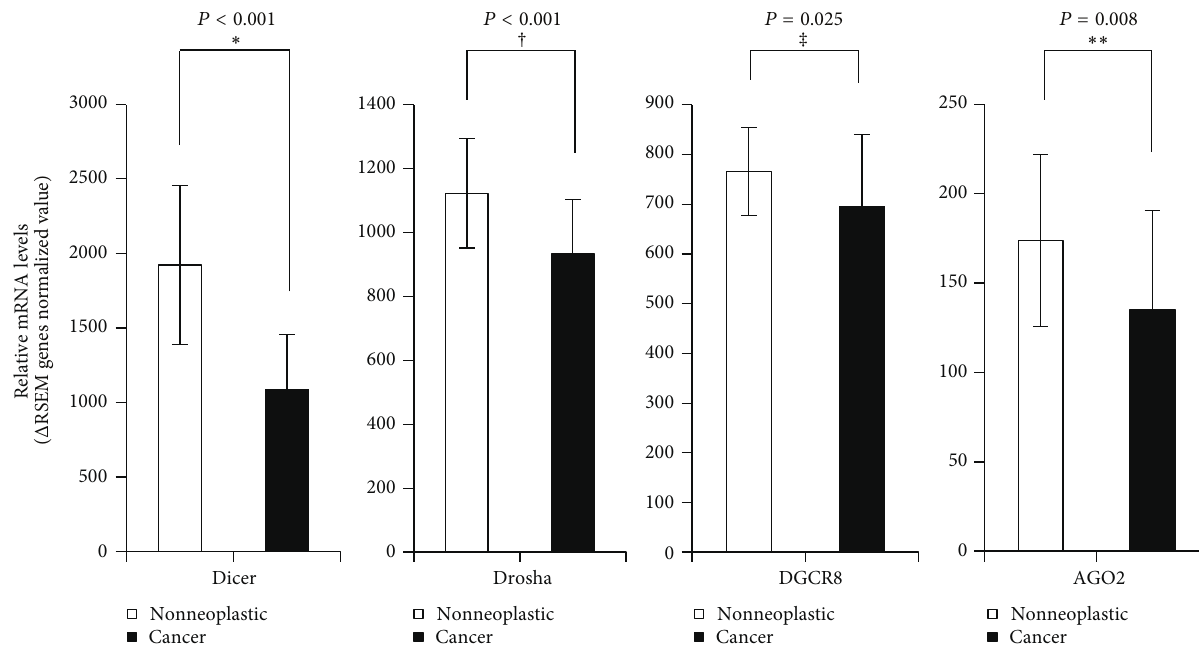
Figure 3: Relative mRNA expressions of Dicer, Drosha, DGCR8, and AGO2 in TCGA PTC data; ∗ 𝑃 < 0.001 , † 𝑃 < 0.001 , ‡ 𝑃 = 0.025 , and ∗∗ 𝑃 = 0.008 . Asterisk indicates Mann–Whitney 𝑈 test. Dagger and double dagger indicate Student’s 𝑡 -test.